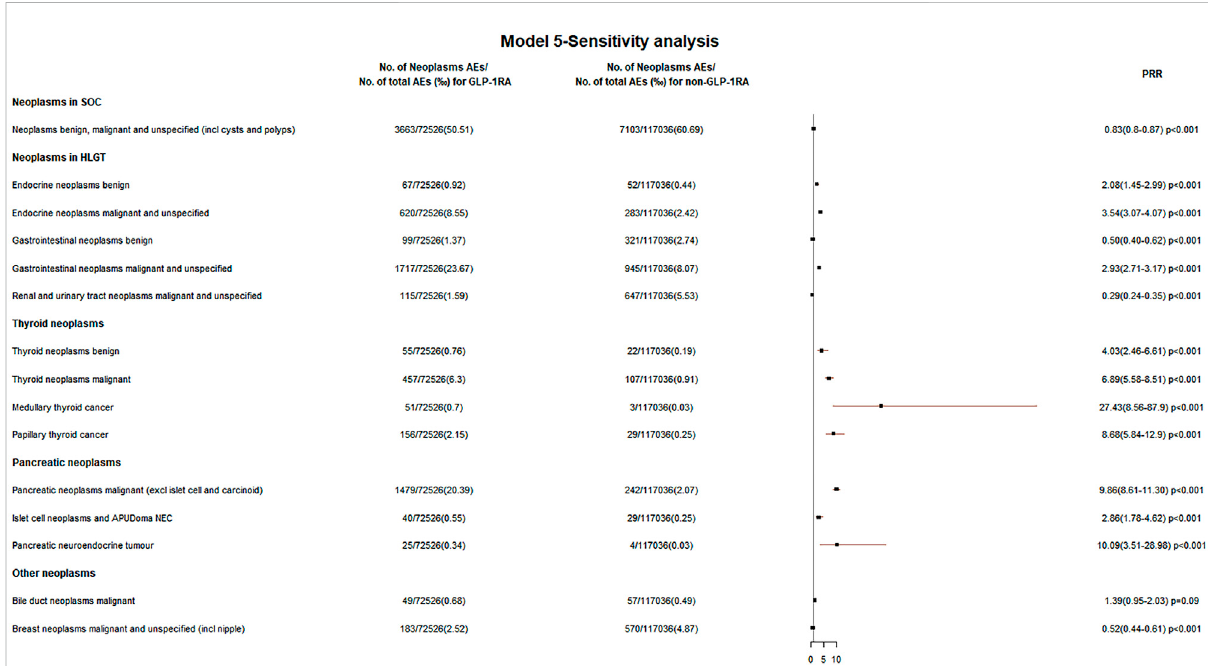
FIGURE 5 Neoplasm reporting rate in model 5 — sensitivity analysis. The neoplasms associated with GLP-1RA compared with other drugs excluding GLP- 1RA (non-GLP-1RA) after excluding all cases with other AEs (retinal adverse events, acute kidney injury, hypoglycemia, nausea, vomiting, diarrhea, and pancreatitis) on the basis of model 4 during 2004 Q1 – 2021